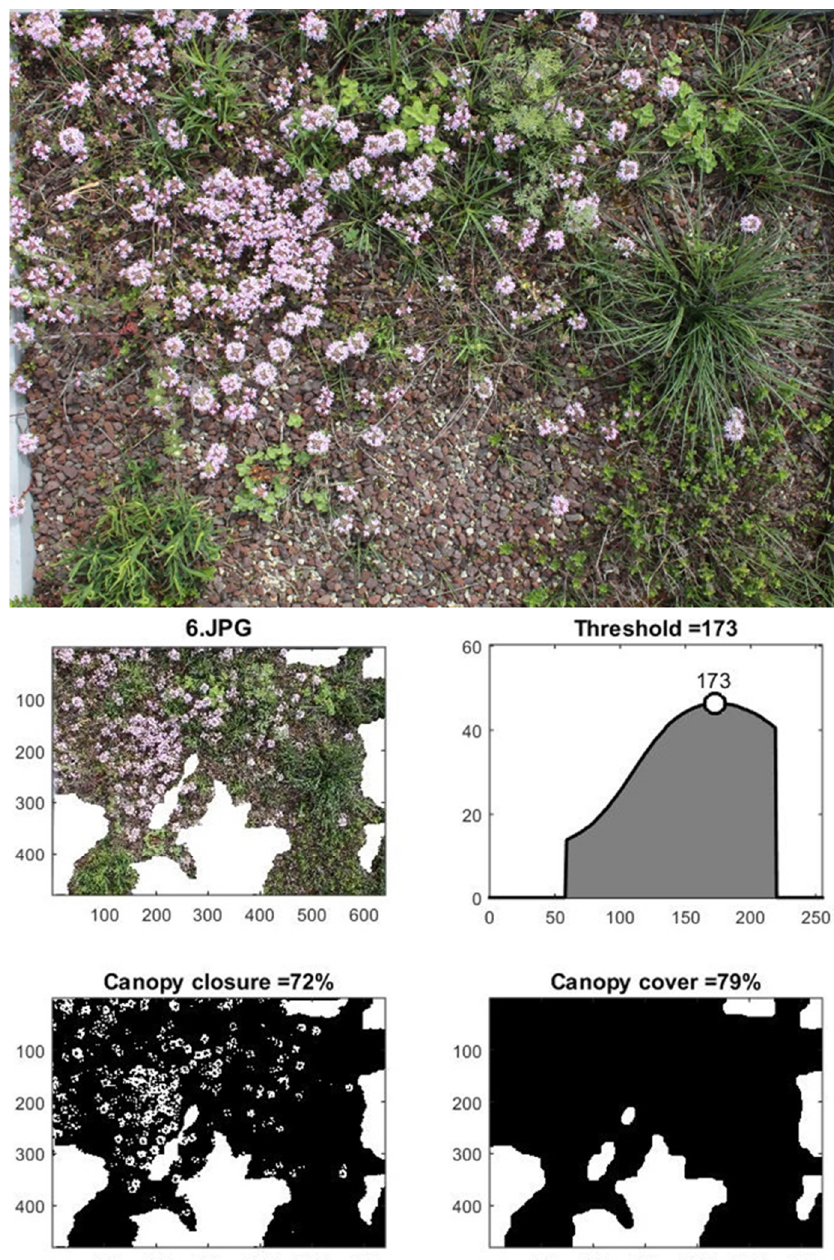
Figure 6. Example of an original photo and its sequence of elaboration.